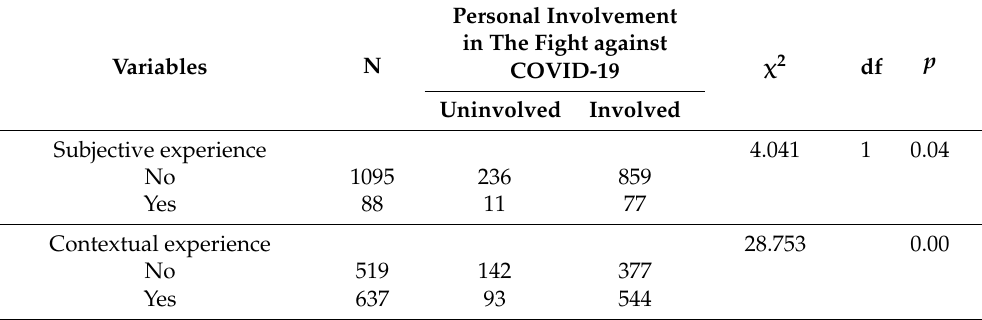
Table 6. Table of associations: Personal involvement in the fight against COVID-19/distance from the